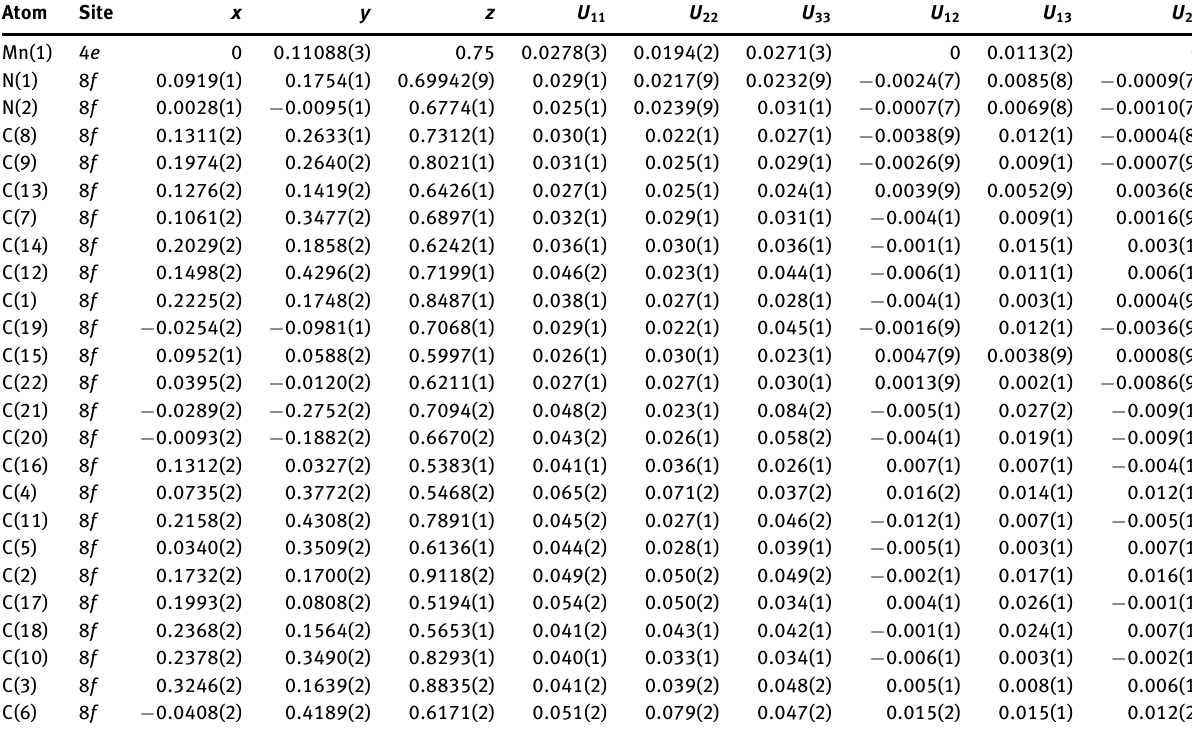
Table 3: Fractional coordinates and atomic displacement parameters (Å 2